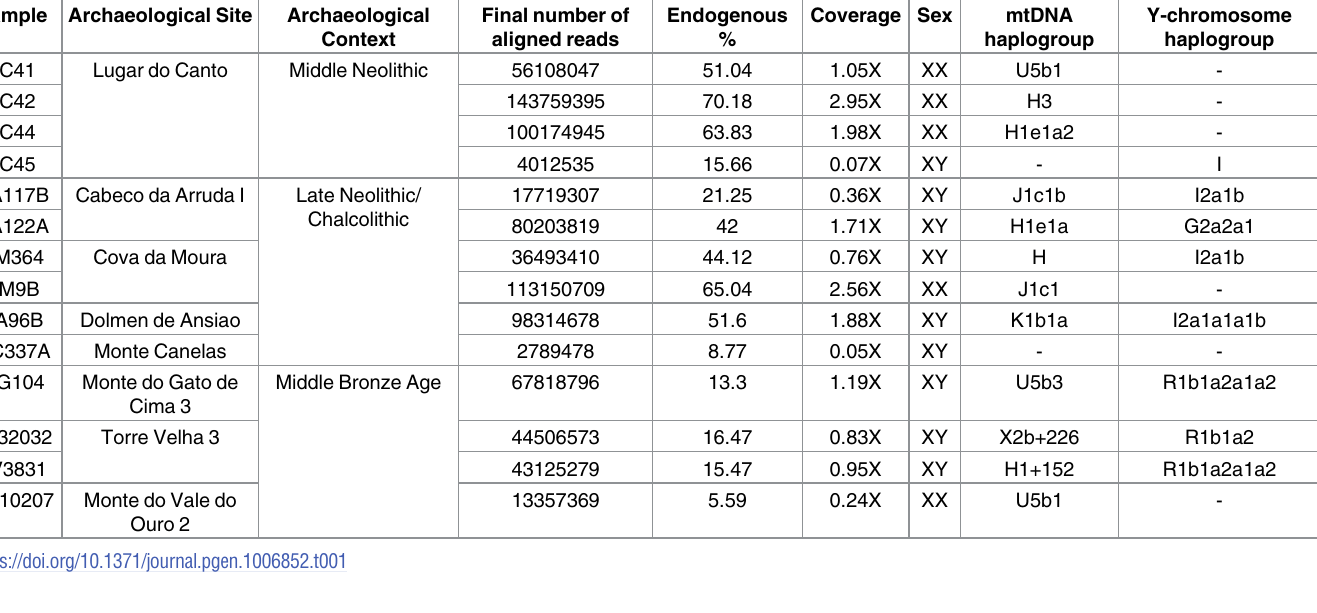
PLOS Genetics | https://doi.org/10.1371/journal.pgen.1006852 July 27,